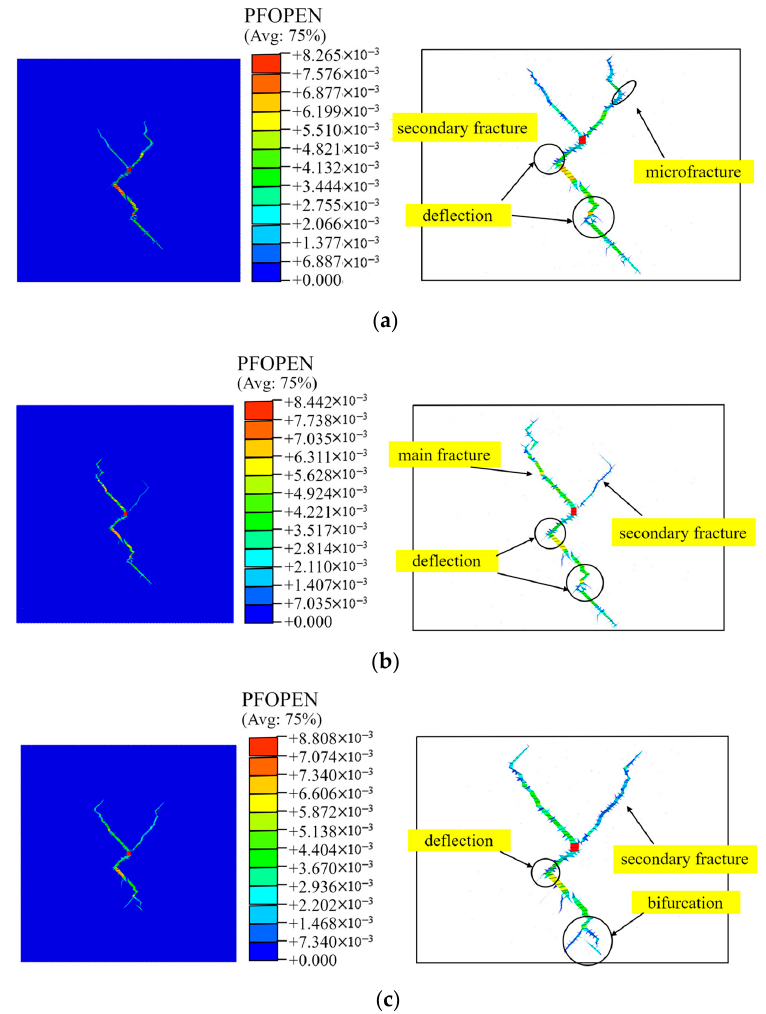
Figure 16. Schematic diagram of fracture morphology in different interface cementing strengths of natural fractures. ( a ) 0.5 MPa. ( b ) 1 MPa. ( c ) 3 MPa.